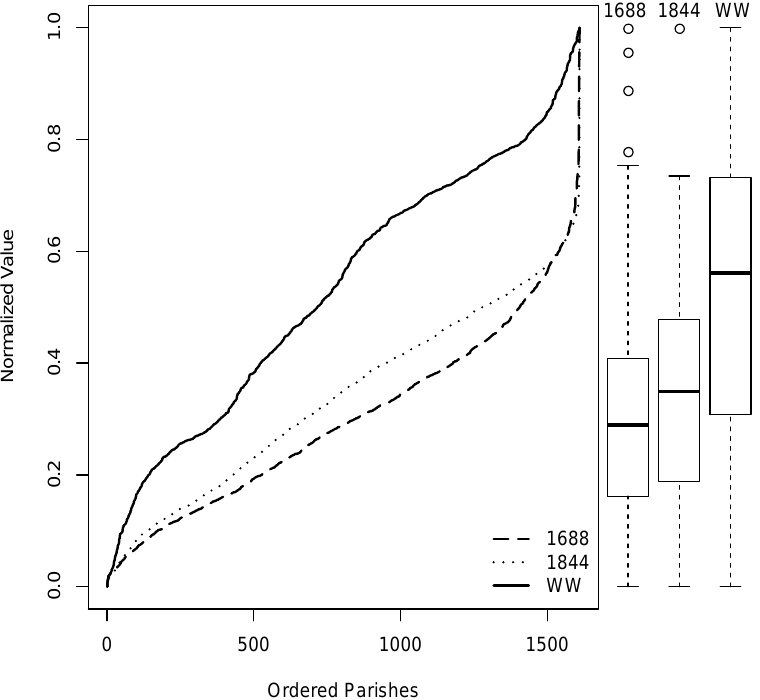
Figure 6. Comparison of the three time periods (WW = current winter wheat yield). Parishes are ordered by normalized values from smallest to largest for each time period